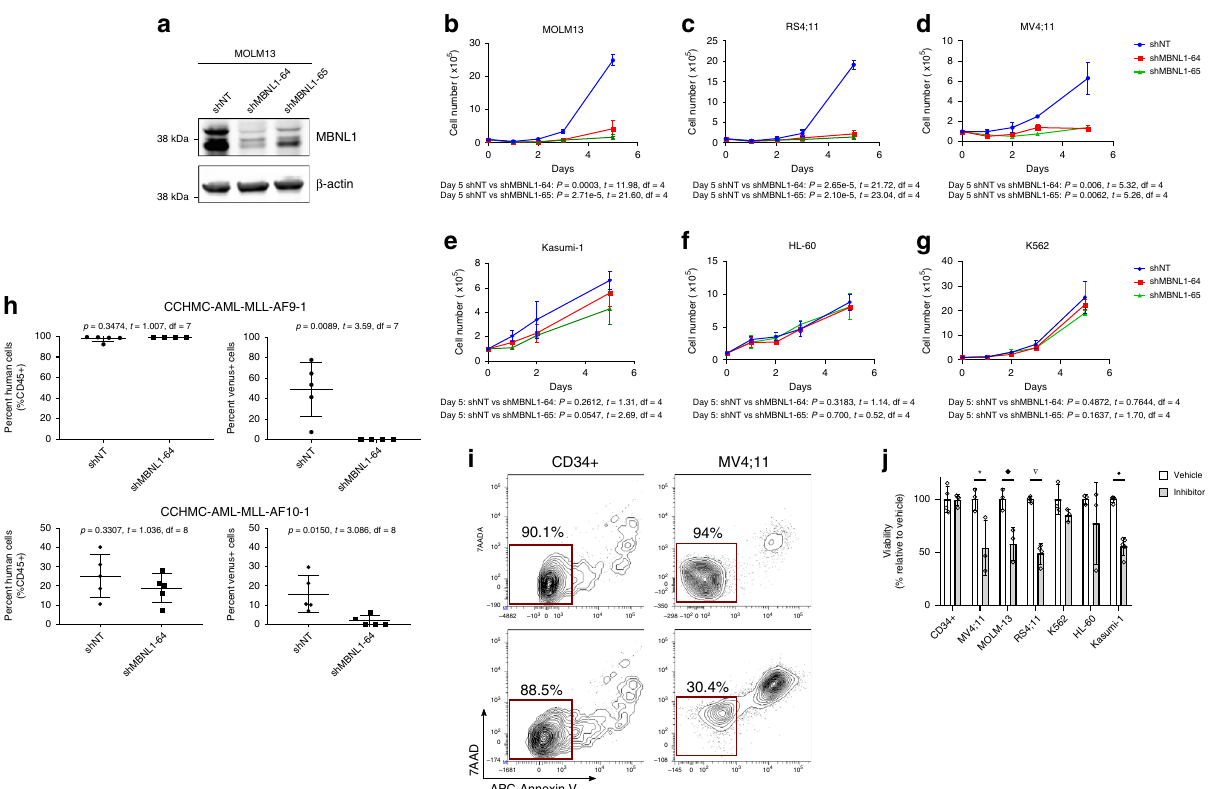
Fig. 2 MBNL1 is required for the propagation of human MLL-rearranged leukemia in vitro and in vivo. a Protein-level effect of MBNL1 knockdown using two different shRNAs (shMBNL1-64, shMBNL1-65). Representative western blot shown, two biological replicates performed. b – g In vitro growth of leukemia cells upon shRNA knockdown of MBNL1 . Data is from three technical replicates. Data shown for MOLM13 ( b ), RS4;11 ( c ), MV4;11 ( d ), Kasumi-1 ( e ), HL-60 ( f ), and K562 ( g ) cells. Day 0 refers to the day transduced cells were isolated by sorting. Cell growth was assessed by counting viable cells using Trypan Blue. Data represent mean±SD. MBNL1 knockdown was con fi rmed through qRT-PCR (Supplementary Fig. 2A, D – H). h Results (scatter plots with mean±SD) of transplant of non-targeting (NT) and MBNL1 knockdown (MBNL1-64) transduced MLL-AF9 and MLL-AF10 primary patient cells. Bone marrow cells were collected from mice ( n = 4 mice in MLL-AF9 shMBNL1-64 group, n = 5 mice in all other groups) at time of leukemic illness. The plots on the left show percentage of human CD45 + cells and the plots on the right show percentage of Venus-positive cells in CD45 + fraction. P values represent comparison between shNT and shMBNL1 conditions by unpaired two-tailed t -test. i CD34 + cord blood cells and MV4;11 human leukemia cells were treated with vehicle or 500 µ M small molecule inhibitor for 18h and assessed for apoptosis. Representative density plots show fl ow cytometry analysis for Annexin V and 7-AAD staining gating on viable cells. j Graph shows relative cell viability by fl ow cytometry (Annexin V/7AAD) 18h after inhibitor versus vehicle treatment in different cell lines. Viability normalized to 100% in vehicle-treated cells. Data represents 3 – 5 biological replicates. Error bars show mean±SD. * p = 0.0465; ◆ p = 0.0173; ∇ p = 5.47e − 5; (cid:129) p = 4.57e – 6 by unpaired two-tailed t -test comparing vehicle vs. inhibitor for each cell